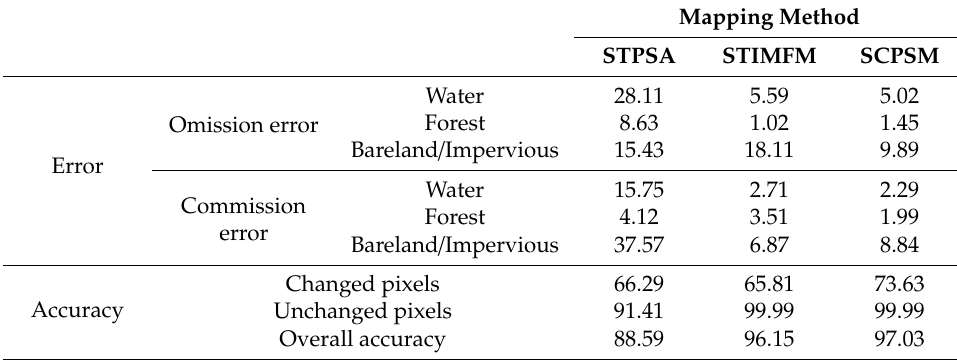
Table 2. The error and accuracies (%) for changed pixels, unchanged pixels and all pixels (overall accuracy) of di ff erent methods in the forest fire